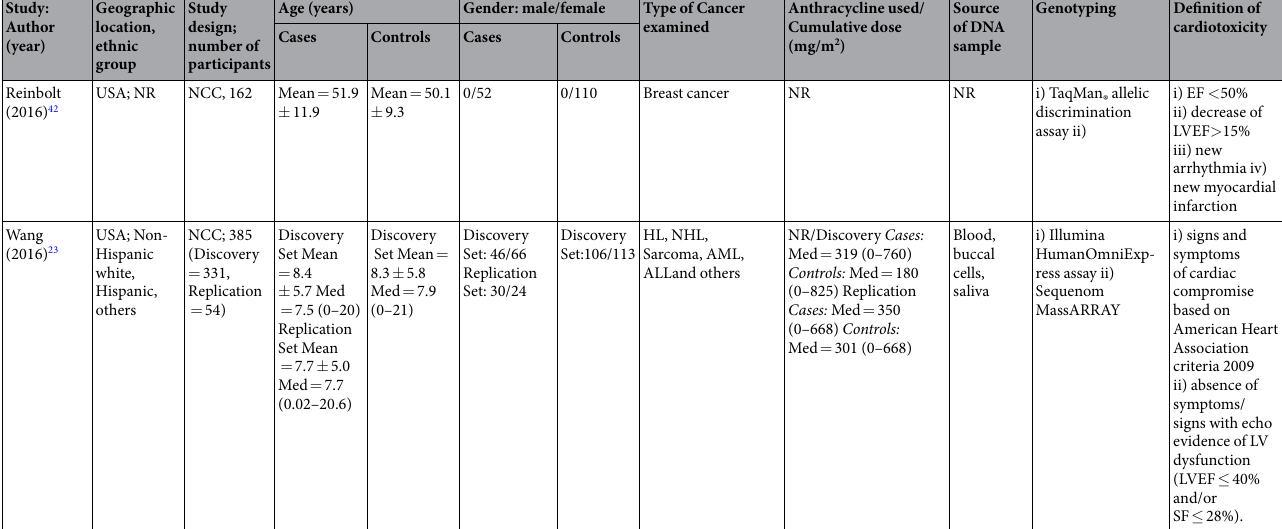
Result Study and patient characteristics.